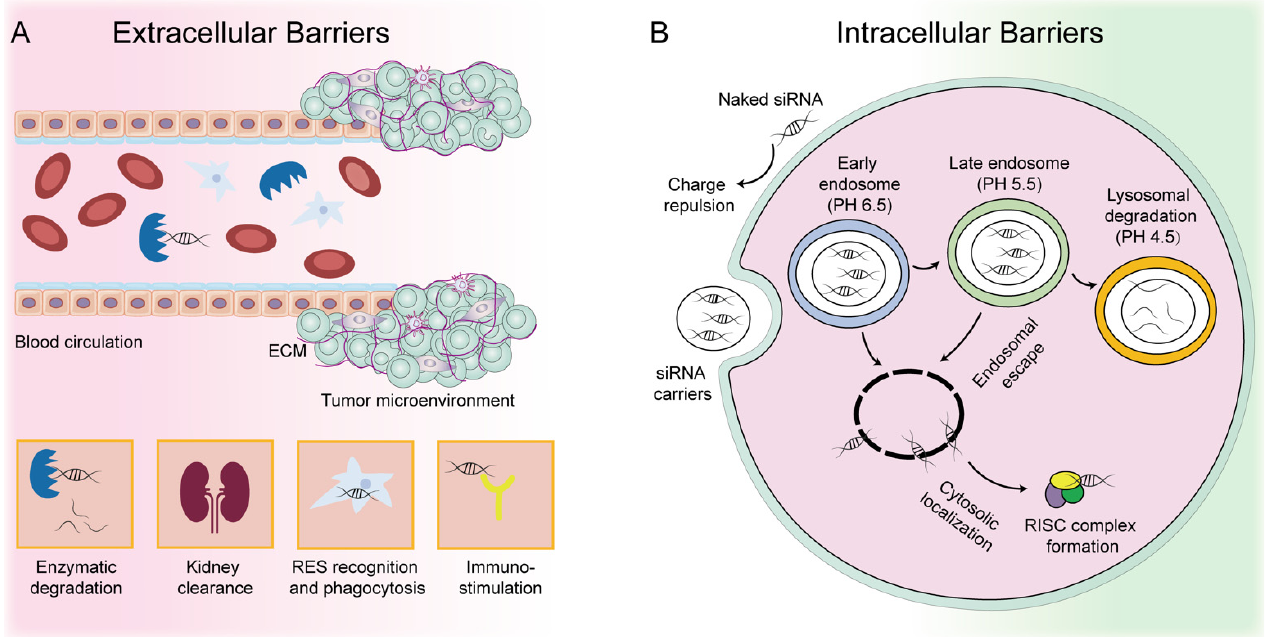
Figure 1. Extracellular and intracellular barriers of siRNA-based cancer therapeutics. ( A ) Extracellular barriers include enzymatic degradation, renal clearance, RES recognition and phagocytosis, activation of immune system and the complex tumor microenvironment. ( B ) Intracellular barriers include endosomal trapping and lysosomal degradation in cancer cells.